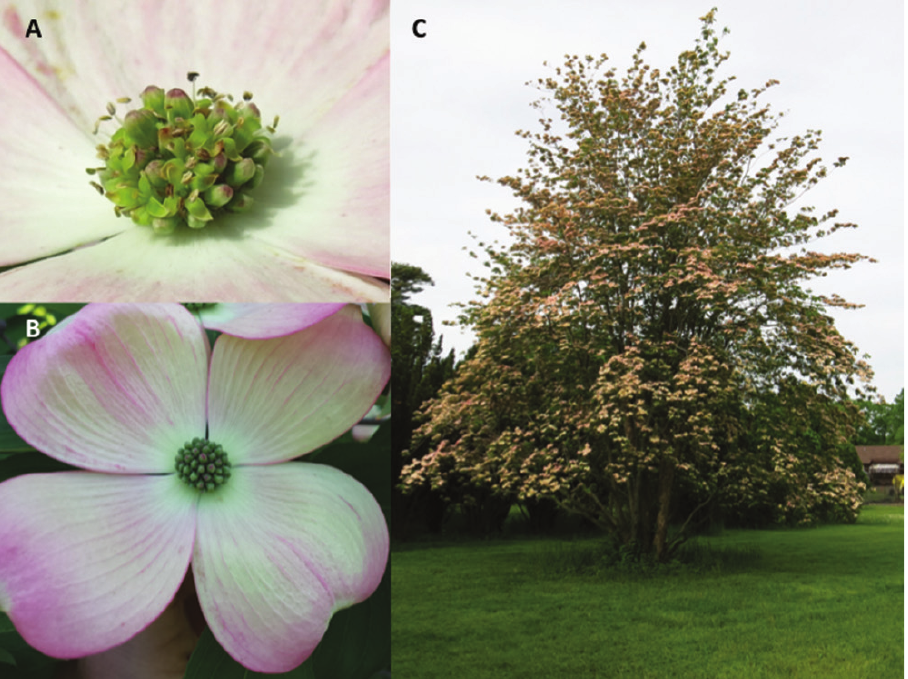
Figure 4. Photos of Cornus × rutgersensis. A Close up of inflorescence, showing varying stages of flowering B Inflorescence with full floral bract display and flowers before anthesis C Habit of mature plant. Photo- graphs A and C by Thomas Molnar; photo B by Robert